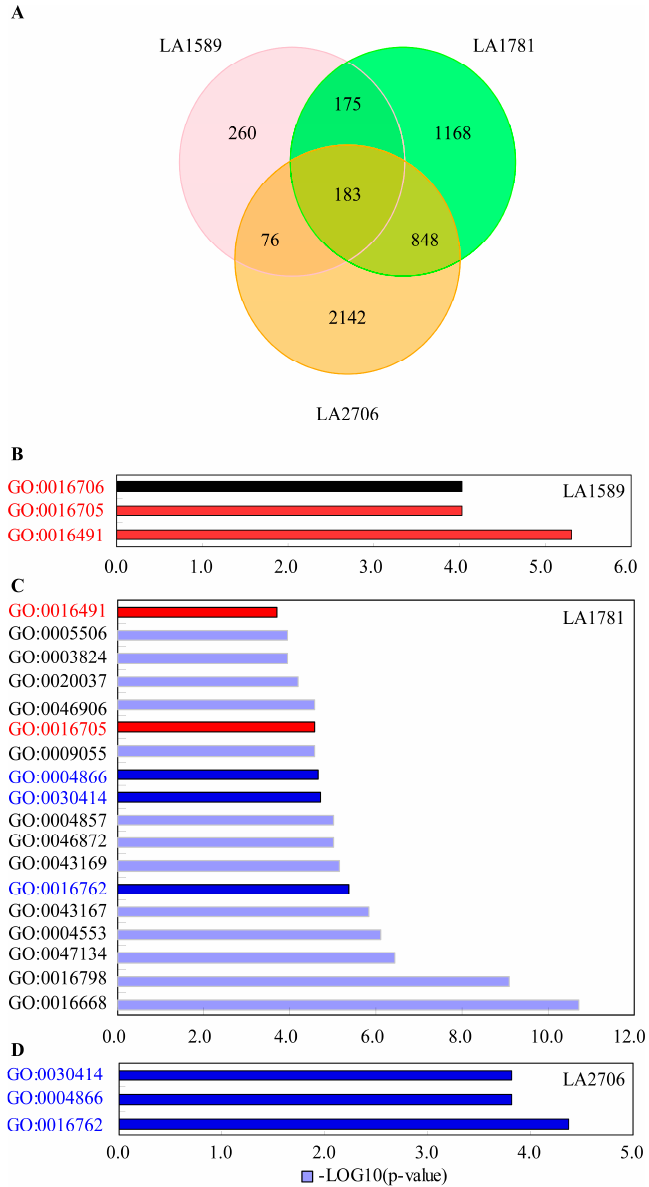
Figure 4. Gene ontology analysis of differentially expressed isoforms between GH and PH conditions. ( A ) Venn diagram of isoforms showing differential expression in response to different growth conditions; ( B – D ) Gene Ontology term analysis of genes with isoforms responding to different growth conditions in LA1589 ( B ); LA1781 ( C ) and LA2706 ( D ), respectively. Enriched GO terms (adjusted p -value < 0.05) include oxidoreductase activity (GO:0016705, GO:0016706, GO:0016491 and GO:0016668), iron ion binding (GO:0005506), catalytic activity (GO:0003824), heme binding